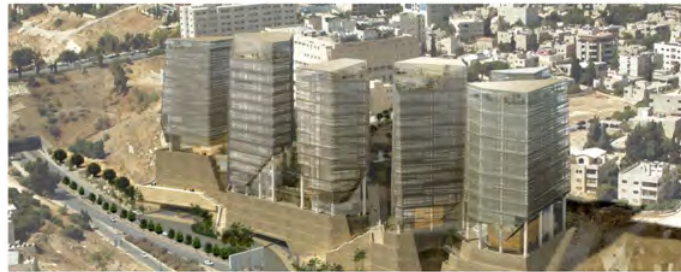
Figure 19. The Living Wall design proposal. Foster+ Partners (2006)